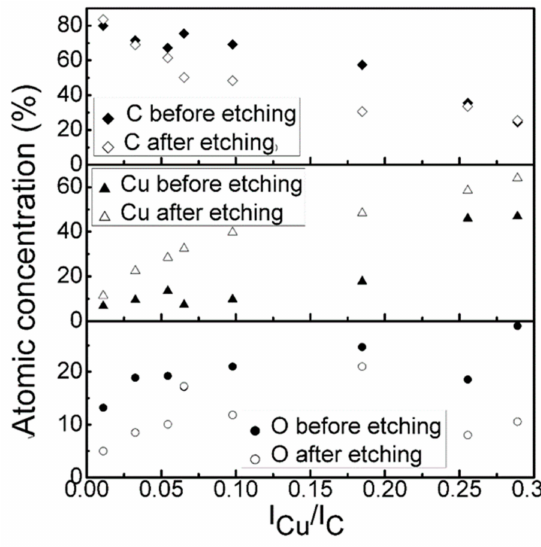
Figure 1. Chemical composition of DLC:Cu films Vs copper and carbon target current